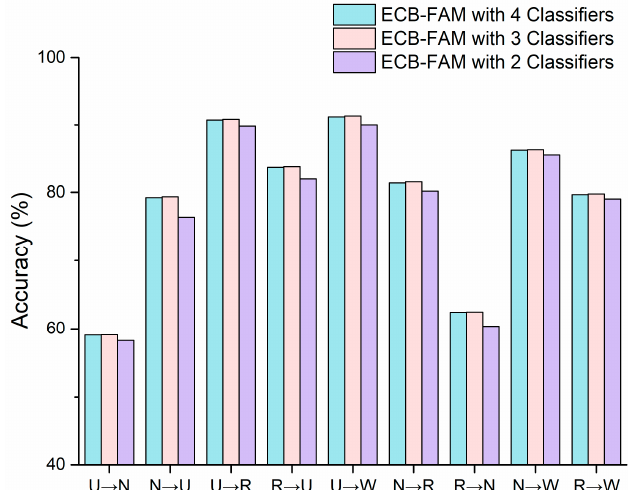
Figure 15. Influence of different numbers of classifiers on the ECB.